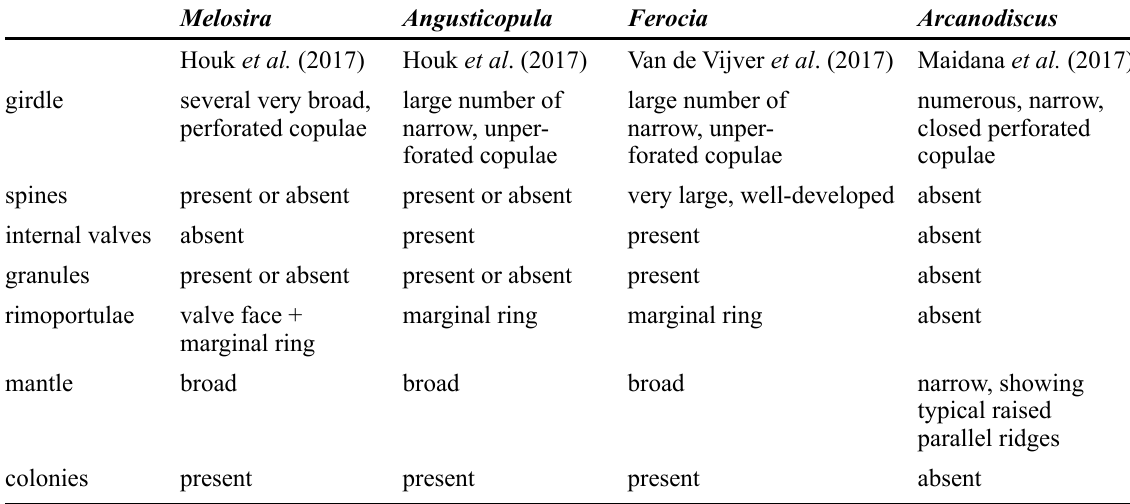
Table 1. Morphological characters of Melosira s. str. and several genera recently split off from Melosira s. lat. Melosira Angusticopula Ferocia Arcanodiscus Houk et al. (2017) Houk et al . (2017) Van de Vijver et al . (2017) Maidana et al. (2017) girdle several very broad, large number of large number of numerous, narrow, perforated copulae narrow, unper- narrow, unper- closed perforated forated copulae forated copulae copulae spines present or absent present or absent very large, well-developed absent internal valves absent present present absent granules present or absent present or absent present absent rimoportulae valve face + marginal ring marginal ring absent marginal ring mantle broad broad broad narrow, showing typical raised parallel ridges colonies present present present